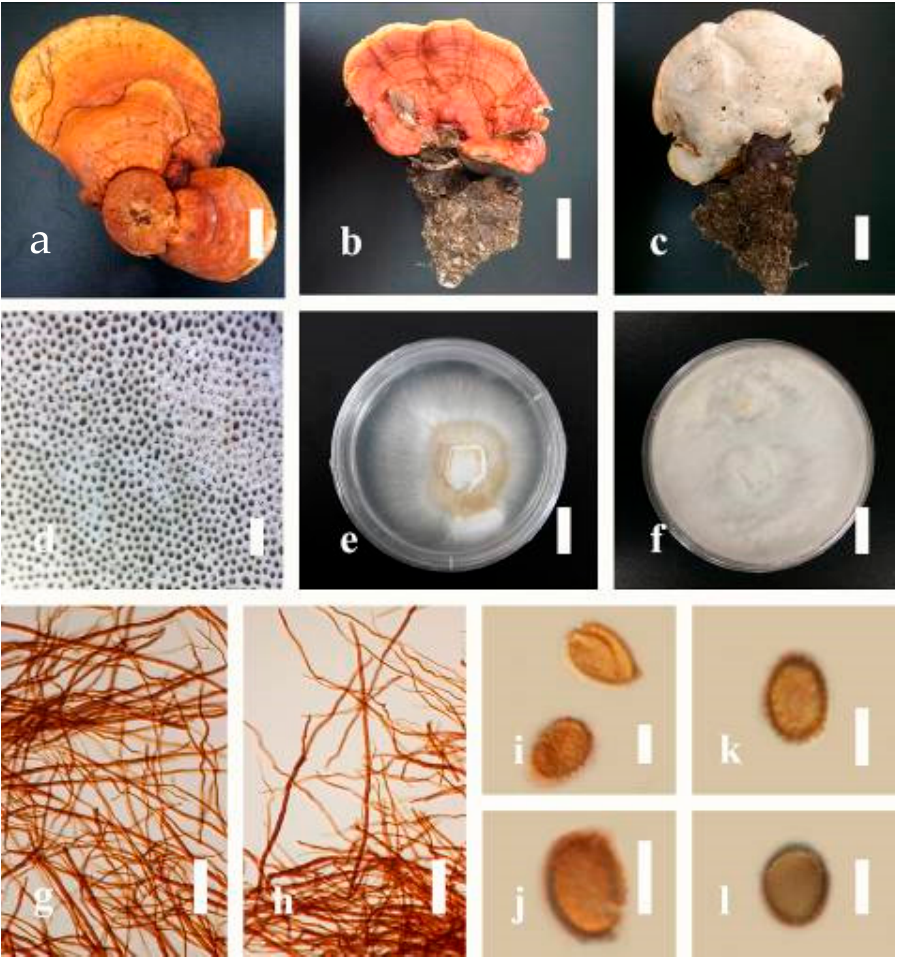
Figure 9. Morphology of Ganoderma leucocontextum : ( a ) mature basidiomes of the strain HKAS 97401; ( b , c ) mature basidiomes of the strain MFLU 19-2160; ( d ) pore characteristics; ( e ) culture after incubation at 25 °C for 14 days; ( f ) culture after incubation at 25 °C for 21 days; ( g , h ) context hyphae in KOH; ( i – l ) basidiospores. Scale bars: ( a , e , f ) = 2 cm, ( b , c ) = 4 cm, ( d ) = 500 μ m, ( g , h ) = 30 μ m, ( i – l ) = 5 μ m.